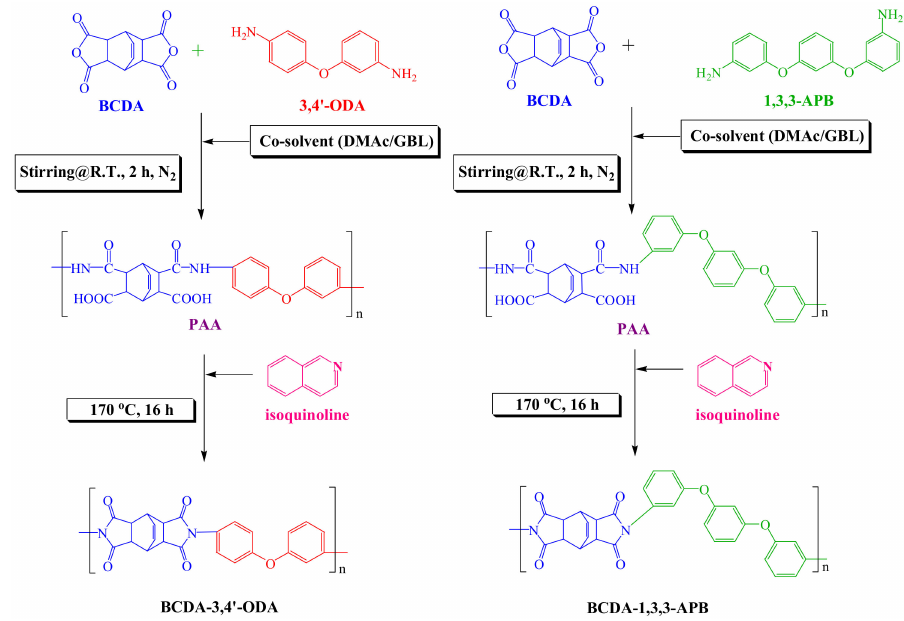
Figure 1. Synthetic routes of alicyclic PIs, BCDA-3,4 (cid:48) -ODA, and